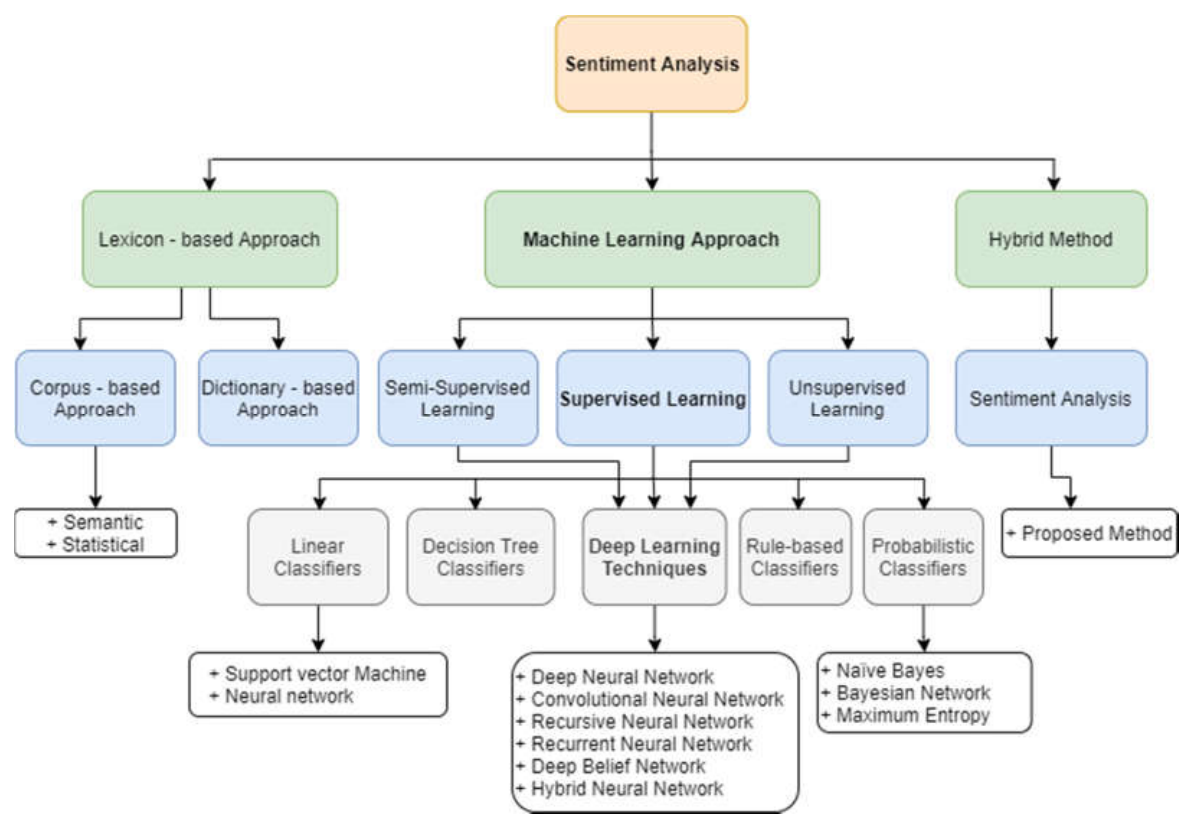
Figure 1. Taxonomy of sentiment analysis techniques. Source: [6,19].